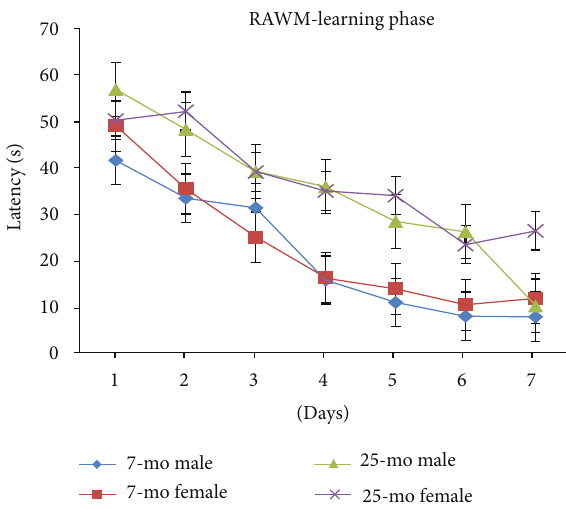
Figure 7: Latencies of 7- and 25-month-old C57BL/6 male and female mice in learning phase of RAWM (s, mean ± SEM).